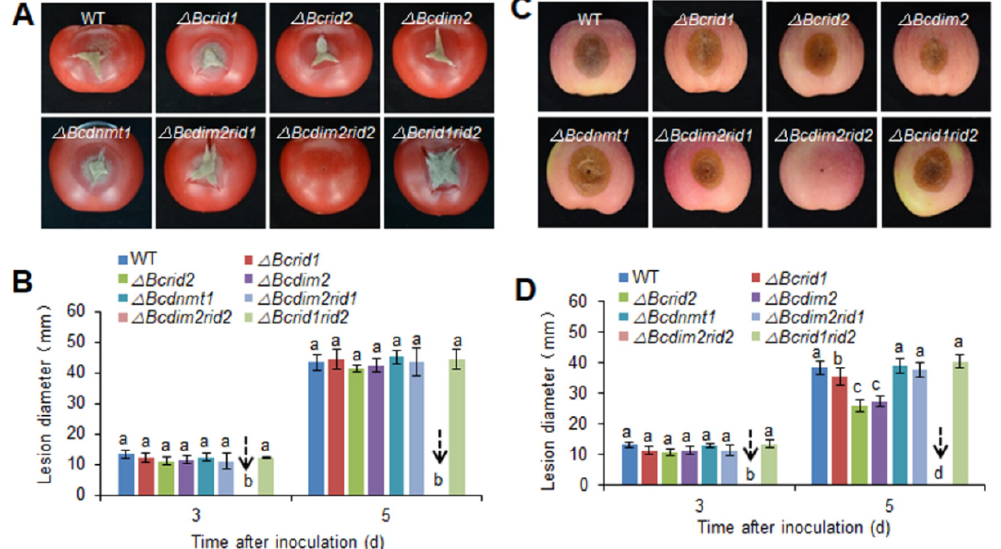
Figure 3. Virulence assay of DNA MTase mutants on fruit hosts. ( A ) Disease symptoms on tomato fruits 5 d after inoculation. ( B ) Lesion diameters on tomato fruits. ( C ) Disease symptoms on apple fruits 5 d after inoculation. ( D ) Lesion diameters on apple fruits. Vertical bars represent standard errors of the means. Columns with different letters indicate significant differences ( p < 0.05).